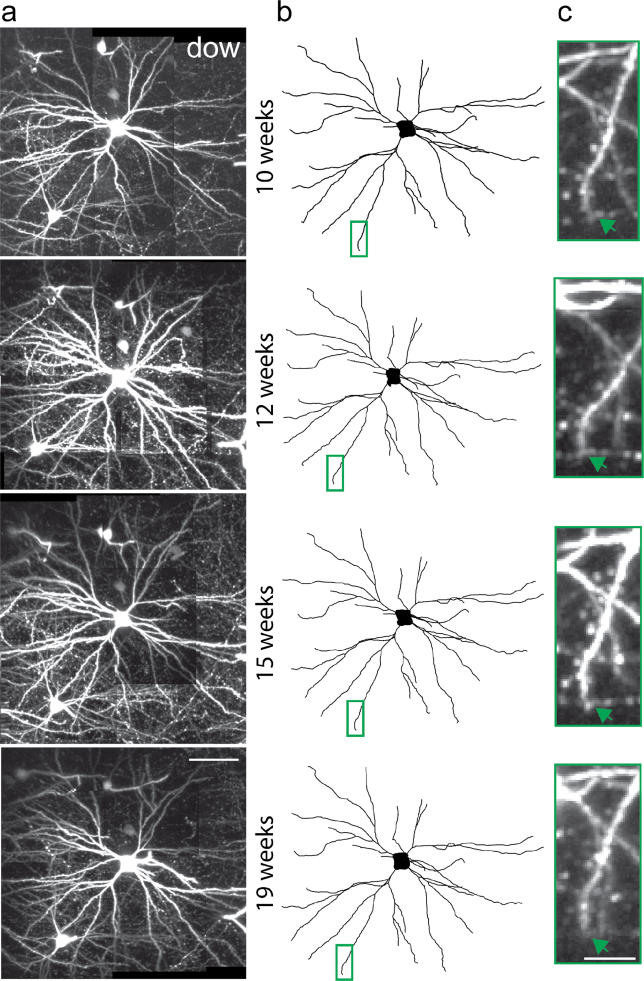
Dendritic Arbors of Pyramidal Neurons Are Stable(A) MZPs near the cell body of the pyramidal cell “dow” acquired over 9 wk.(B) Two-dimensional projections of three-dimensional skeletal reconstructions of “dow.”(C) High-magnification view of branch tip (green arrow) in region outlined by green box in (B).Scale bars: (A and B), 50 μm; (C), 10 μm.